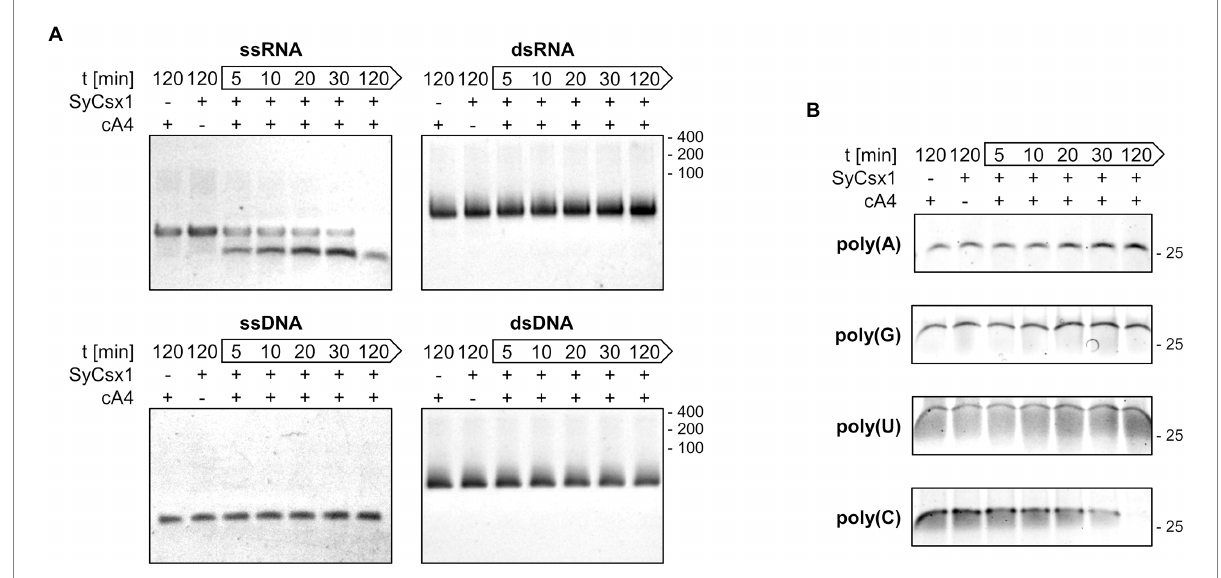
FIGURE 3 SyCsx1 is a single-strand-specific ribonuclease with a strict preference for cytosine bases. (A) Cleavage of 5 μ M single- and double-stranded RNA or DNA oligonucleotides (40 nt) by SyCsx1 at 30 ° C after the addition of 300 nM cA4. 10 μ l aliquots of were sampled at indicated time points, separated on 12% denaturing PAA gels, and stained with ethidium bromide. (B) 25 nt RNA-homopolymers were incubated with SyCsx1 and cA4 at 30 ° C and analyzed as before, except that SybrGold was used for